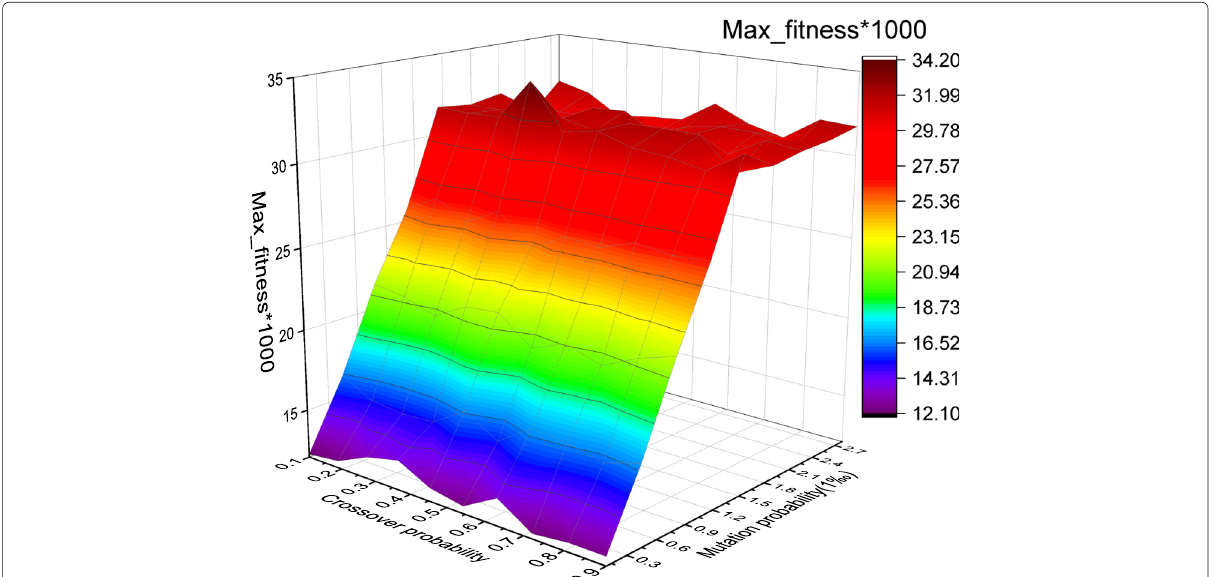
Fig. 13 Impact of C P and M P on maximum